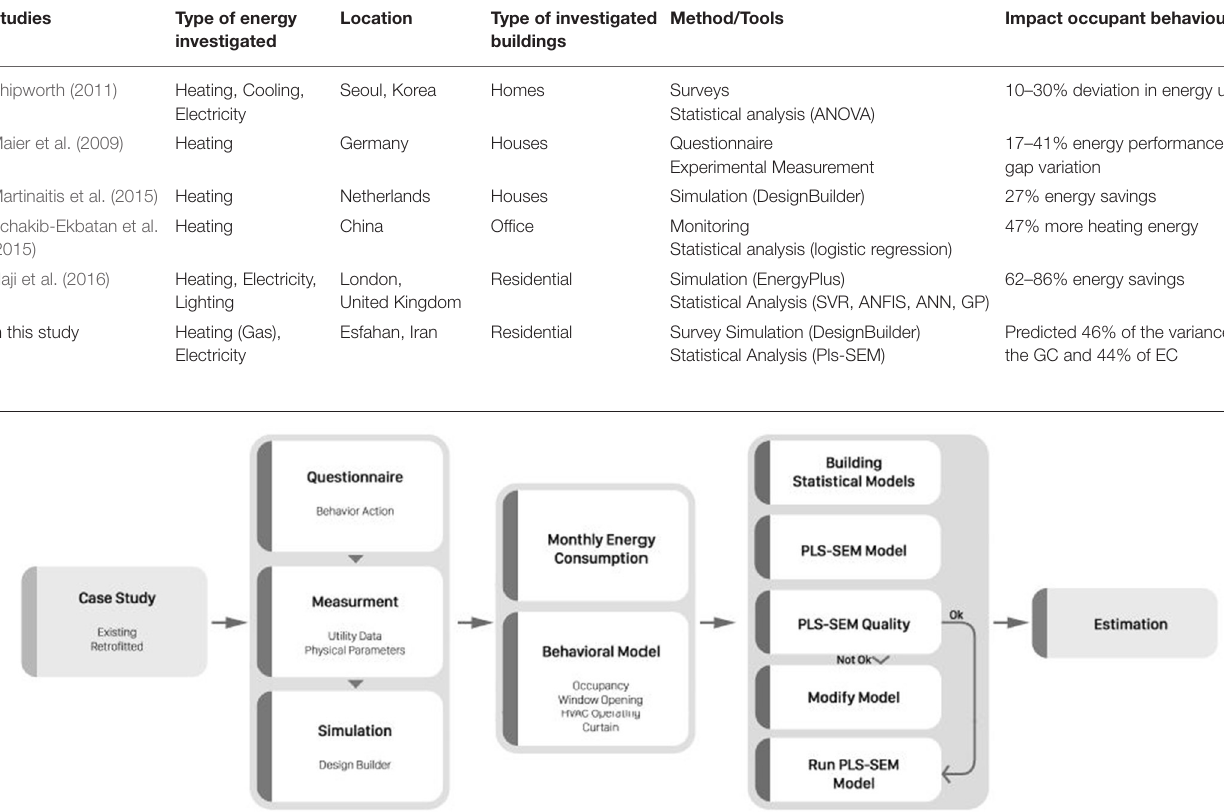
FIGURE 1 | Research methodology